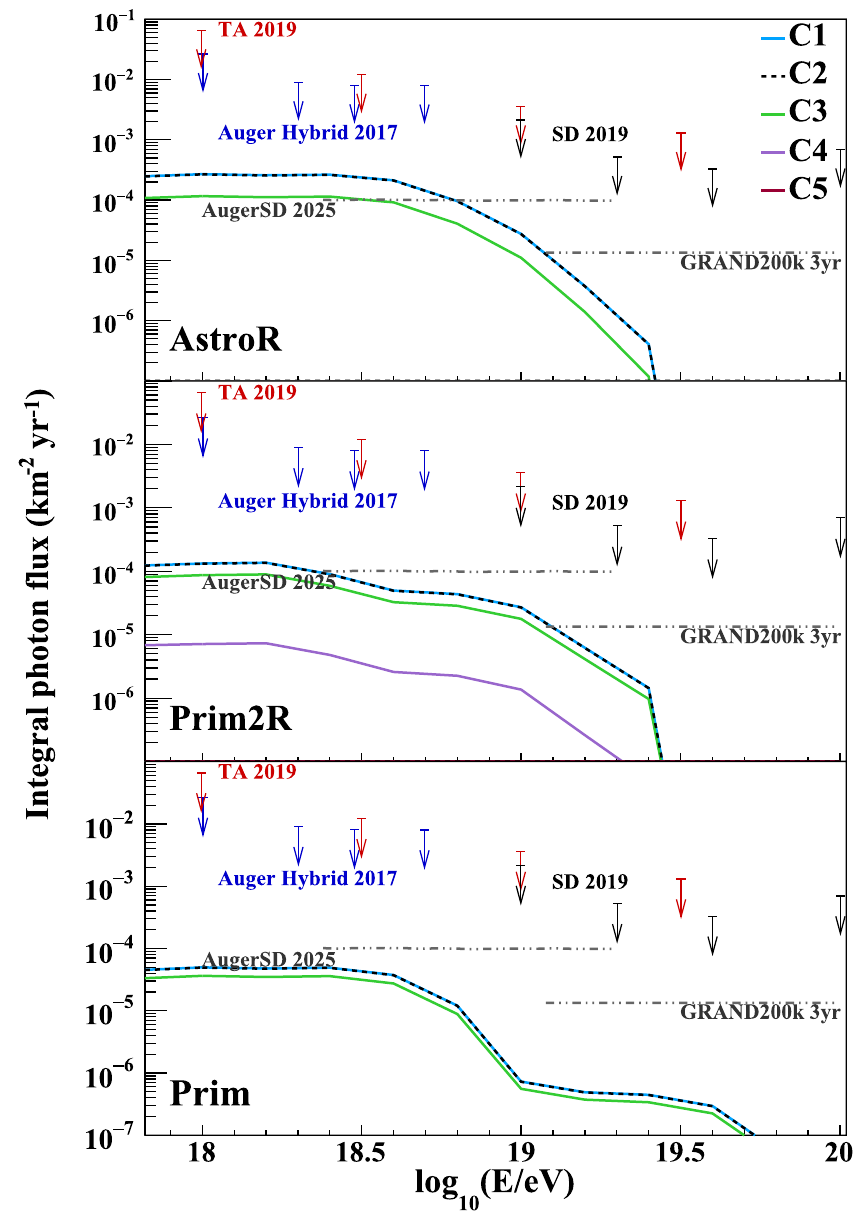
Fig. 9 Integral photon flux and limits in the highest energy limit. The three EGMF models (AstroR, Prim2R and Prim) and five composition abundance (C1–C5) are shown. Arrows show the upper limits measured by Telescope Array (TA 2019) [60] and by the Pierre Auger Observatory (Auger Hybrid 2017 [61] and SD 2019 [62]). The projected sensitivity for the Pierre Auger Observatory in 2025 (AugerSD 2025 [62]) and for GRAND (GRAND200K 3 years [22]) are also